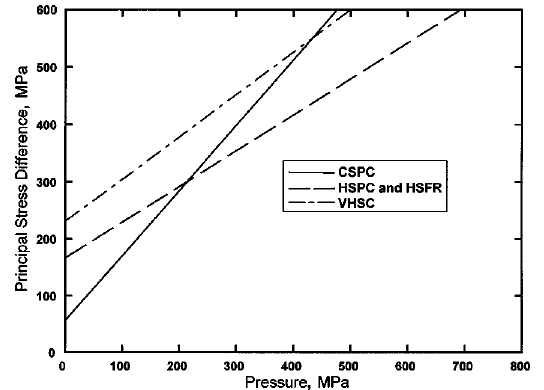
Fig. 6. Yield surfaces used in the spherical-cavity expansion model for the CSPC, HSPC, HSFR, and VHSC concretes.